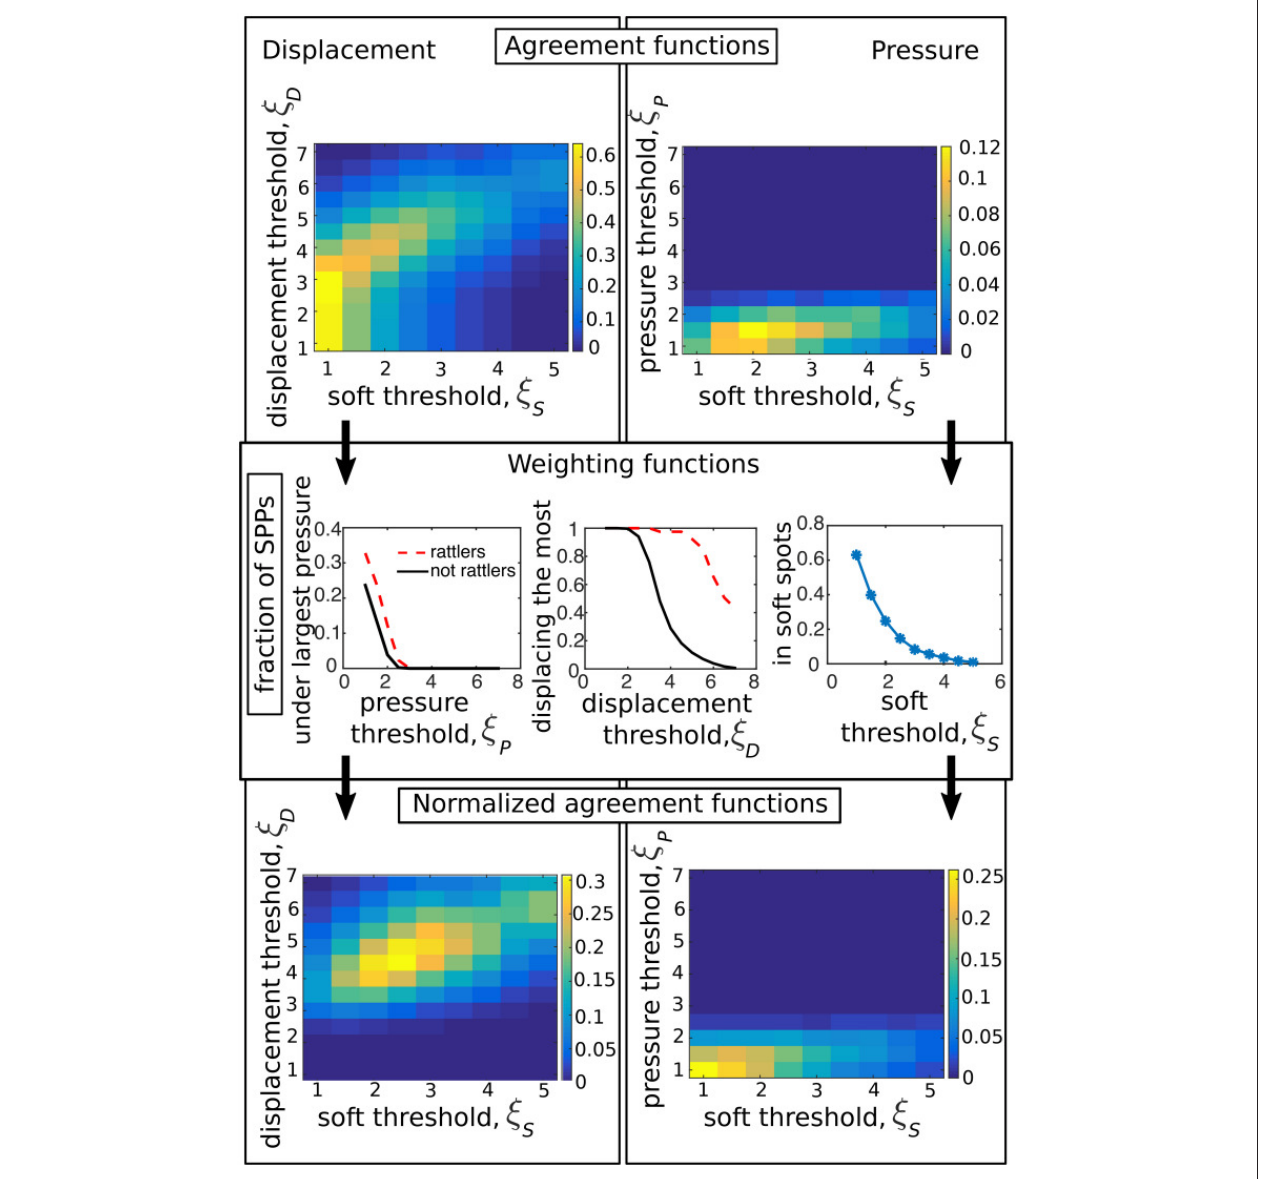
FIGURE 7 | The agreement functions for the correlation between being in a soft spot ( S ), undergoing large pressure ( P ), and large displacement ( D ) before (top) and after (bottom) the normalization by the weighting functions (center) that measure the size of the sets S , P , D . Arrows indicate the logical procedure followed to obtain the normalized agreement